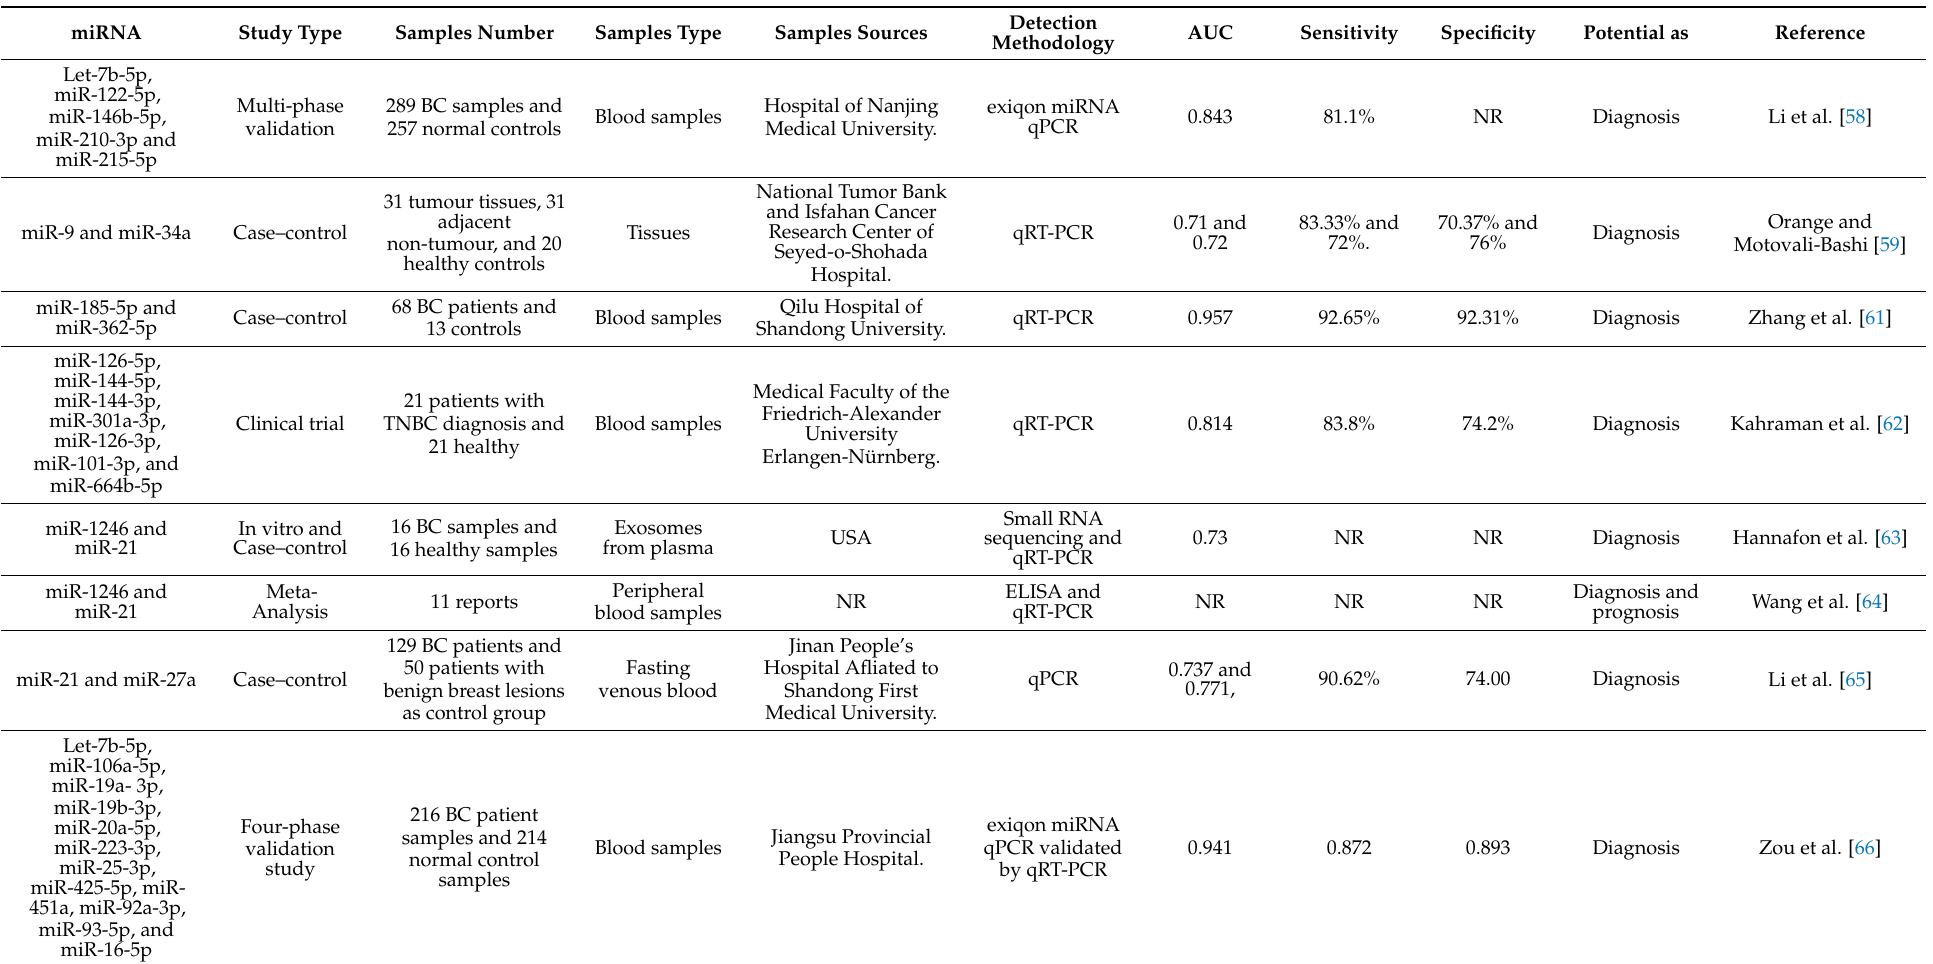
Table 1. Impact of microRNAs on cancer-derived metastatic